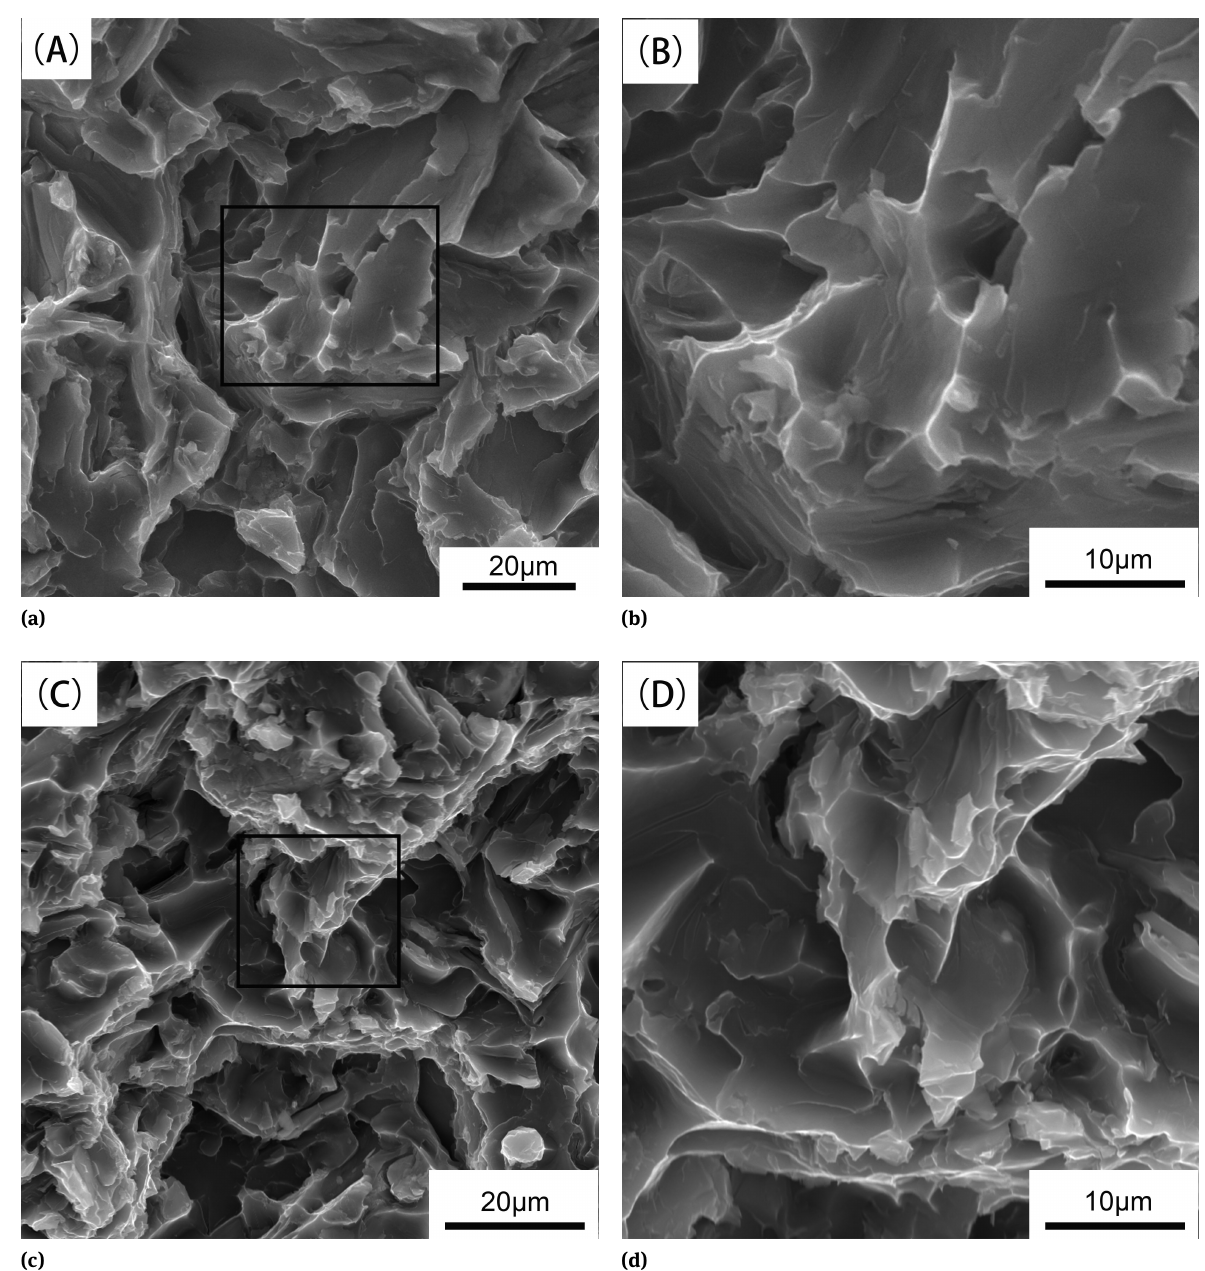
Figure 7: SEM images of tensile fracture surfaces of composite (a) low magnification without ultrasonic assistance; (b) high magnification without ultrasonicassistance; (c) low magnification with ultrasonic assistance; (d) high magnification with